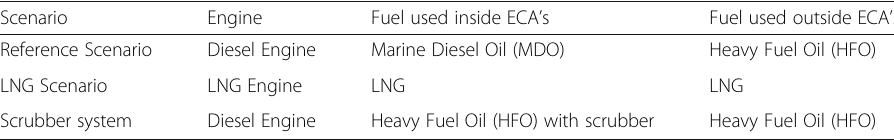
Table 11 Different scenarios based on the type of